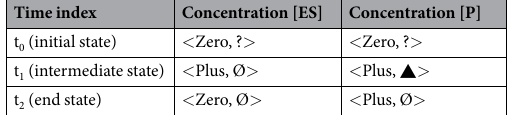
Table 1. TB of the qualitative features the curves in Fig. 1. ‘?’ can be one of { ▼ , Ø, ▲